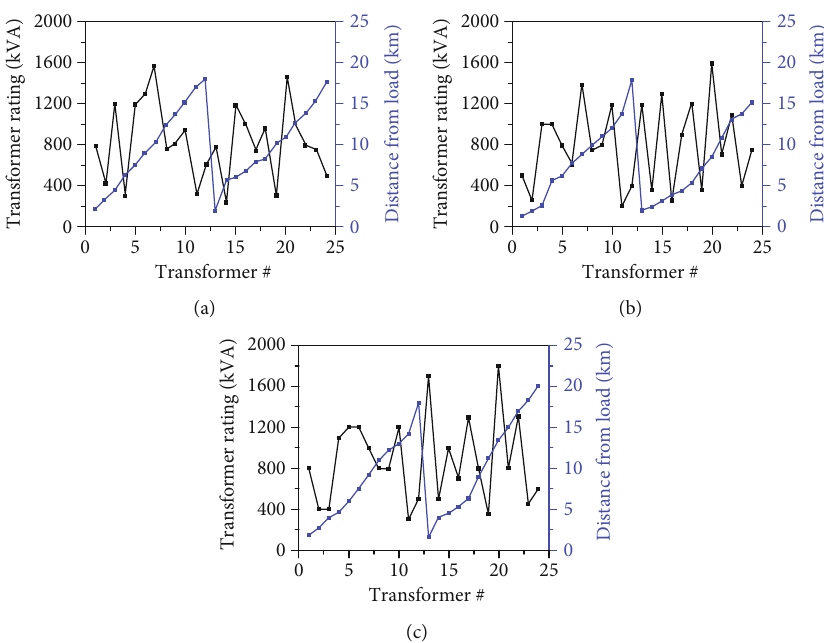
Figure 7: Transformer ratings and route lengths in (a) zone A, (b) zone B, and (c) zone C.